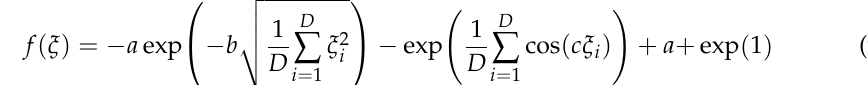
Figure 2. Model image of different functions: ( a ) Griewank function and ( b ) Ackley function. The Ackley function, which is characterized by a nearly flat outer region and a large hole at the center (see Figure 2b), is used to test the global convergence and is defined as: